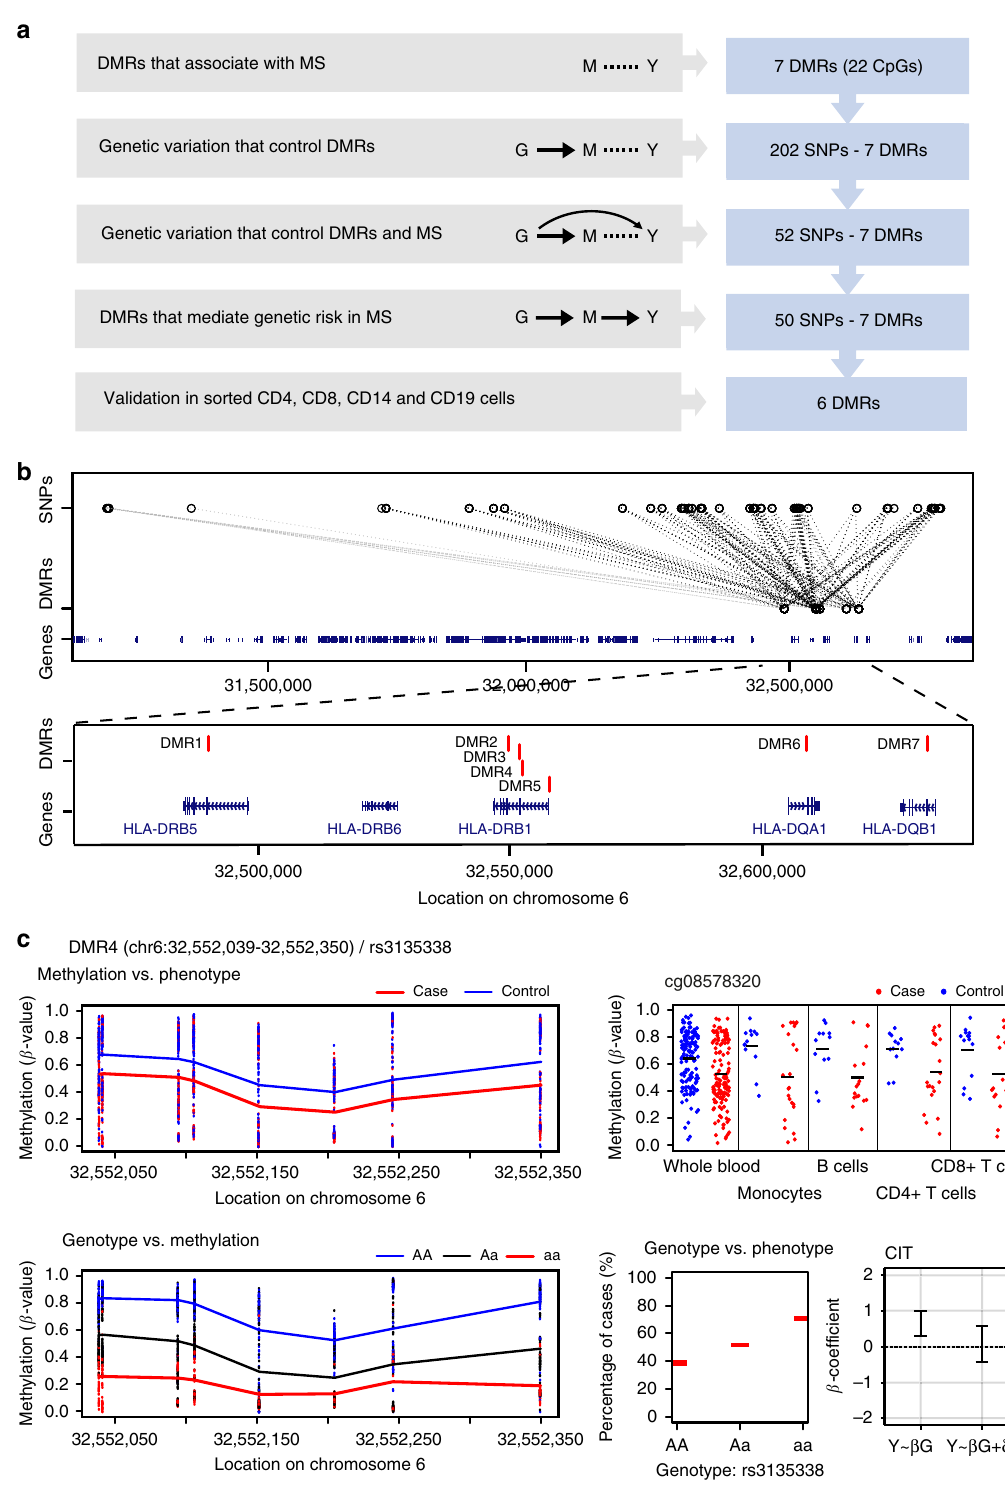
MS cases and controls for six out of the seven DMRs using